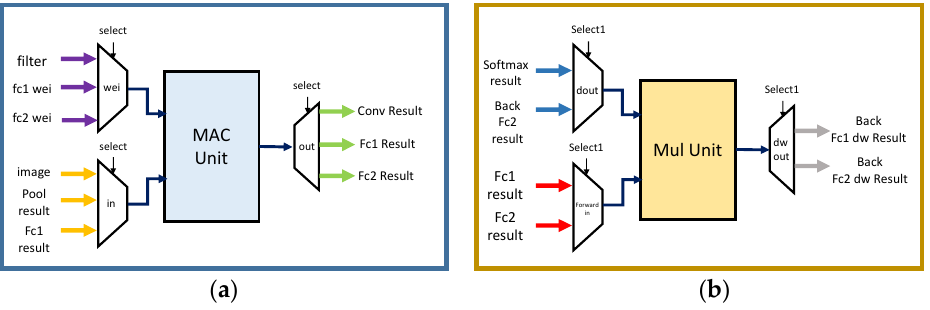
Figure 14. Resource sharing of operations for forward and backward propagation. ( a ) Multiplier and add operation for convolution and FC; ( b ) multiplier for calculate gradient of weight in FC.